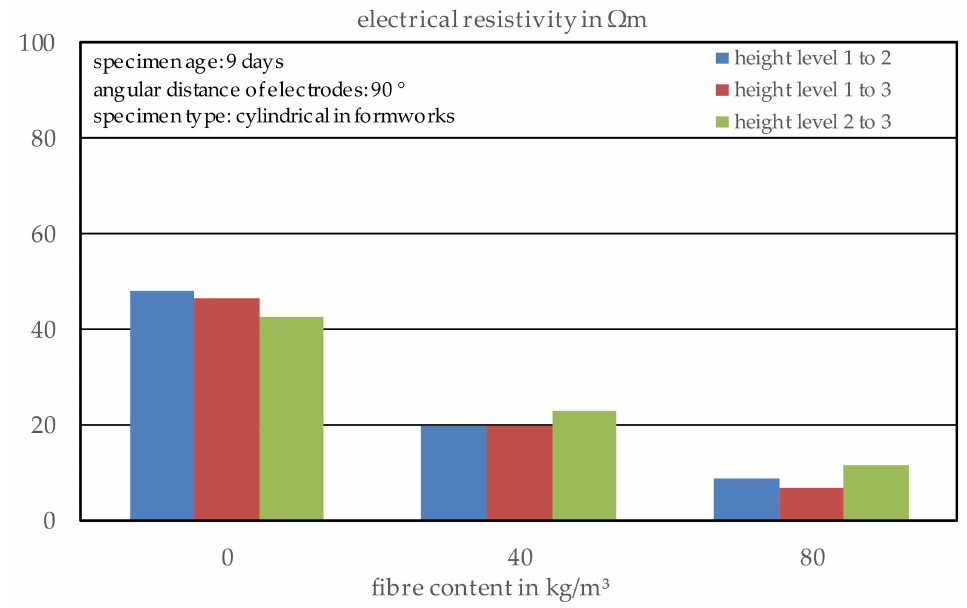
Figure 10. Electrical resistivity in the vertical direction with different combinations of electrodes depending on fibre content at a specimen age of 9 days and an electrode array with angular distances of 90 ◦